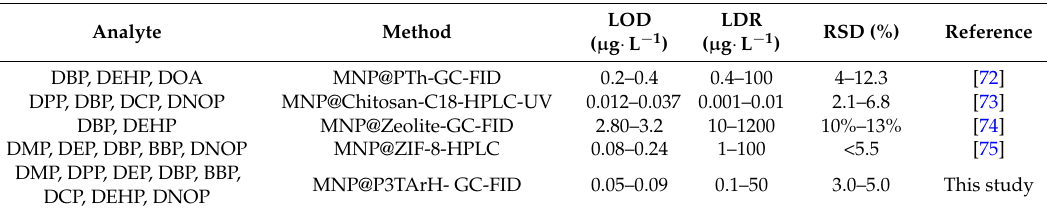
Table 3. Comparatives study of the proposed method with other MSPE adsorbents for the extraction of phthalates.